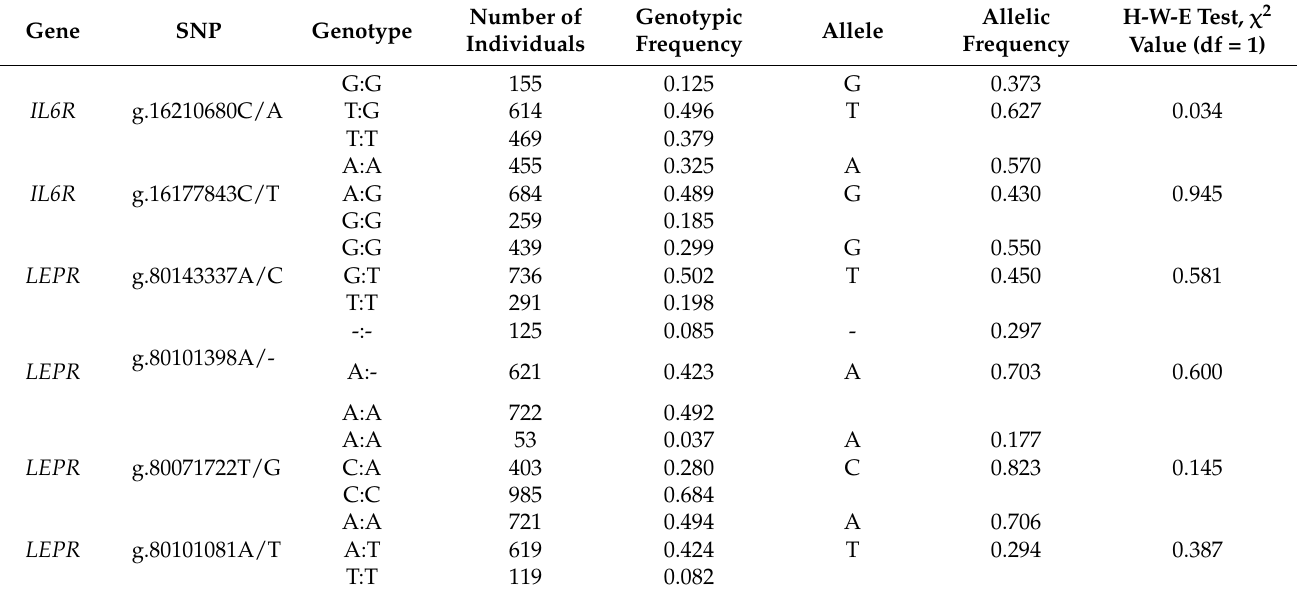
Table 1. The detail information of six SNPs within the gene IL6R and LEPR in 1588 Holstein